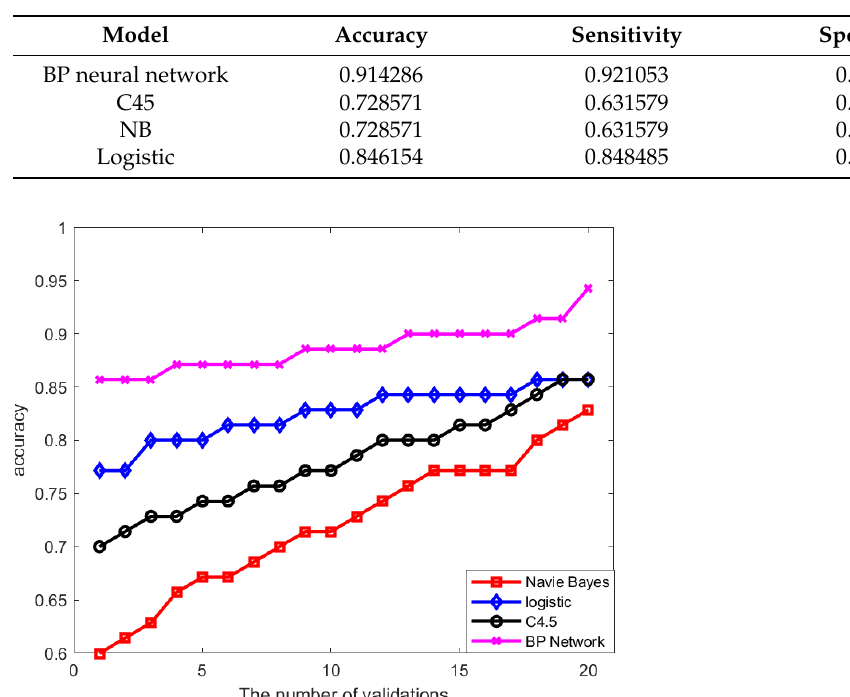
Table 5. Evaluation of each model.